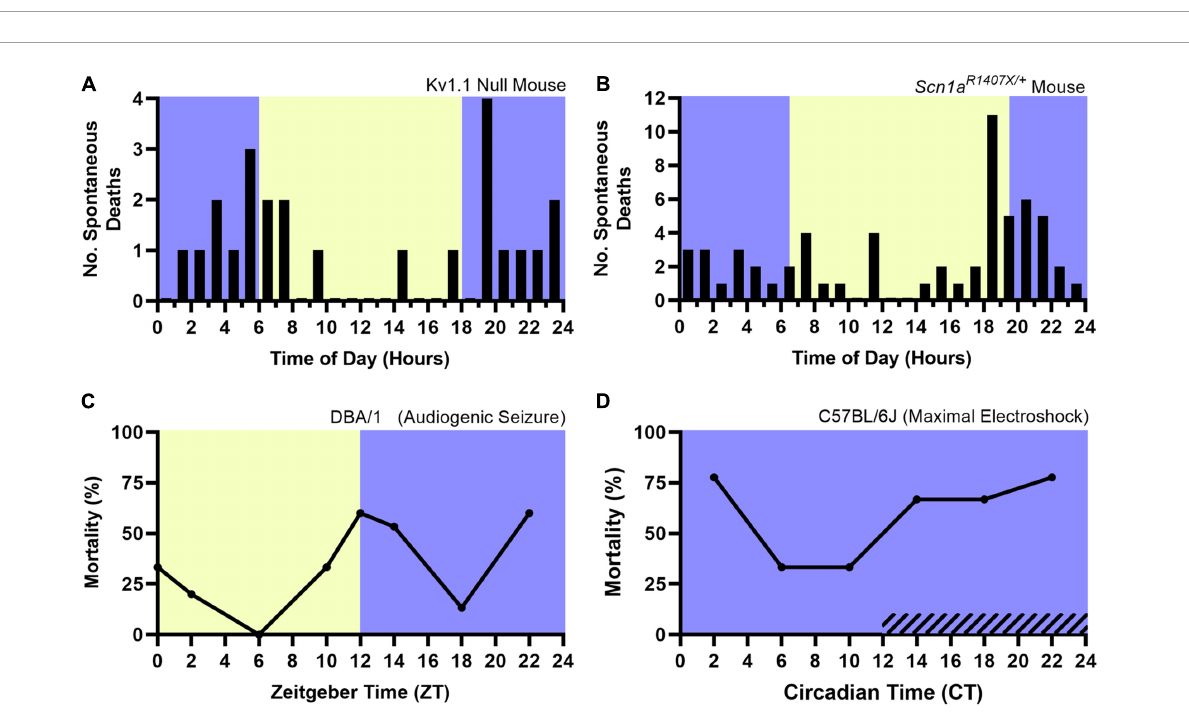
FIGURE5 Nocturnal death in spontaneous and induced seizure mouse models. The nocturnal tendency of seizure-associated death has been shown in the Kv1.1 Null Mouse (A) and Scn1a R 1407 X / + mouse model of Dravet Syndrome (B) , both which experience spontaneous,